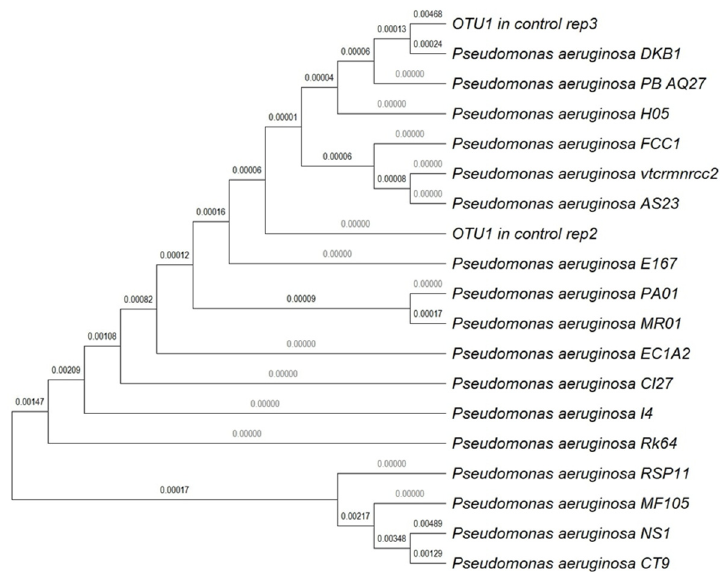
Figure 6. Phylogenetic tree built by the neighbor-joining method by MEGA11.